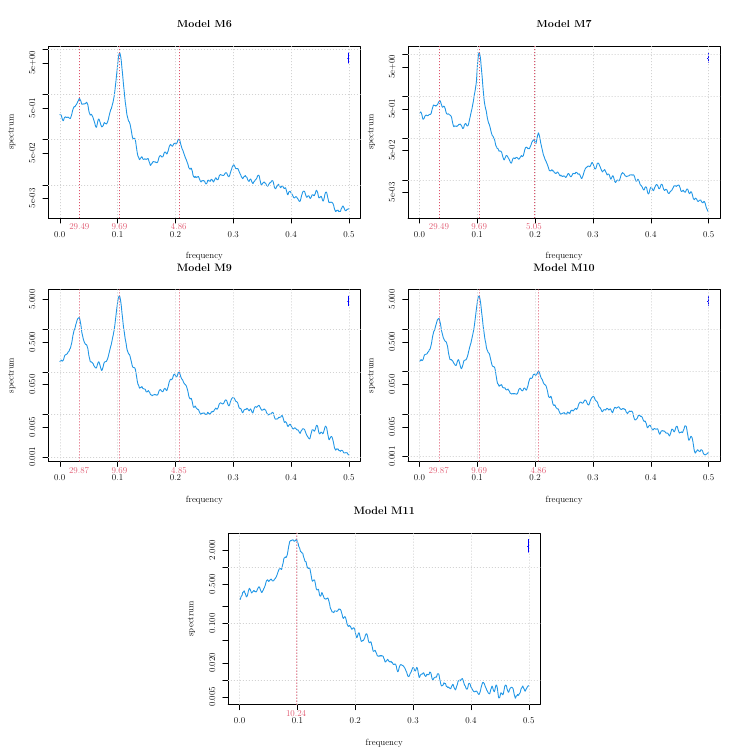
Figure 7 – Spectral density of time series of length 10000 simulated from TARMA models. The dashed line indicate the prominent pikes and the corresponding periods are